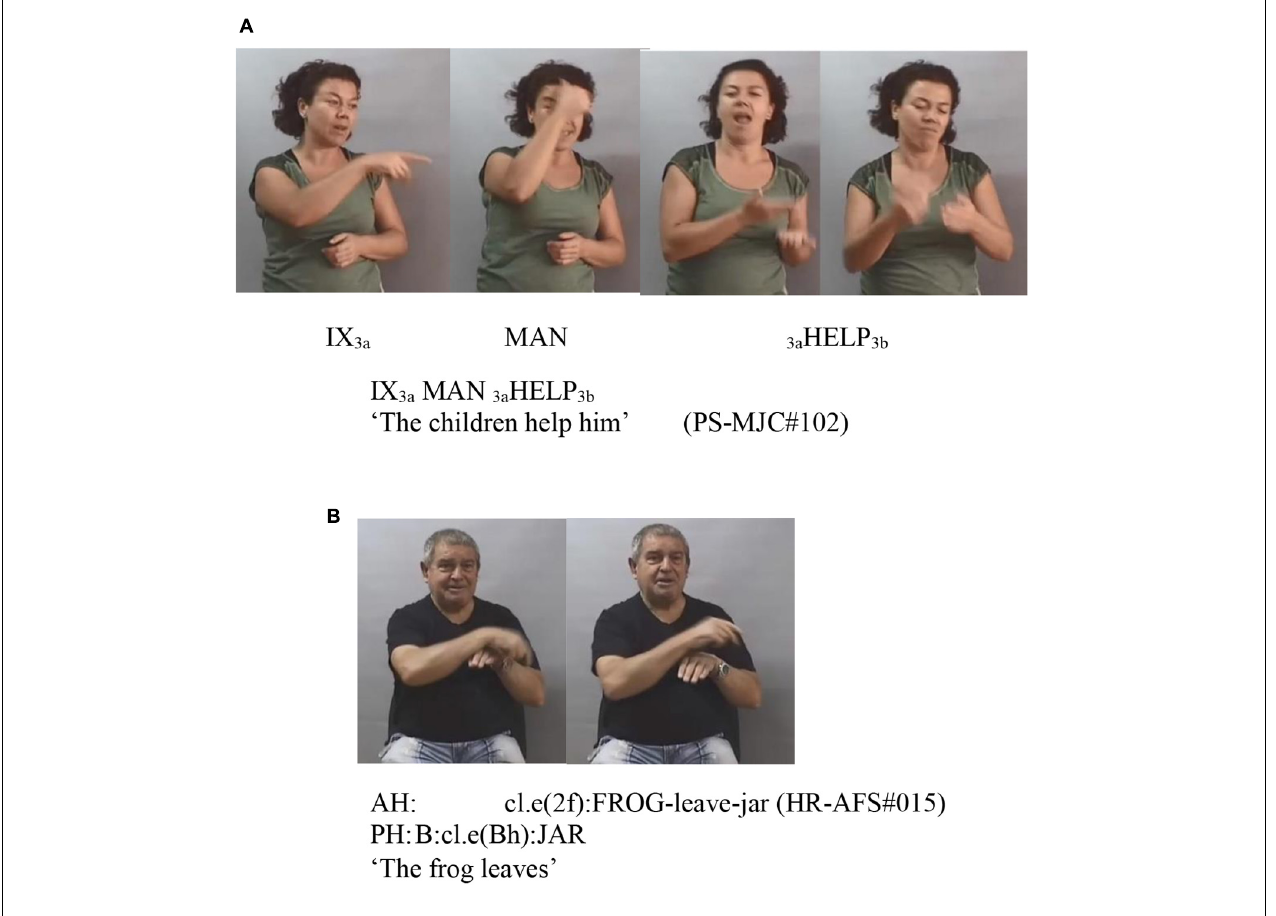
FIGURE 1 | Examples (A,B) .